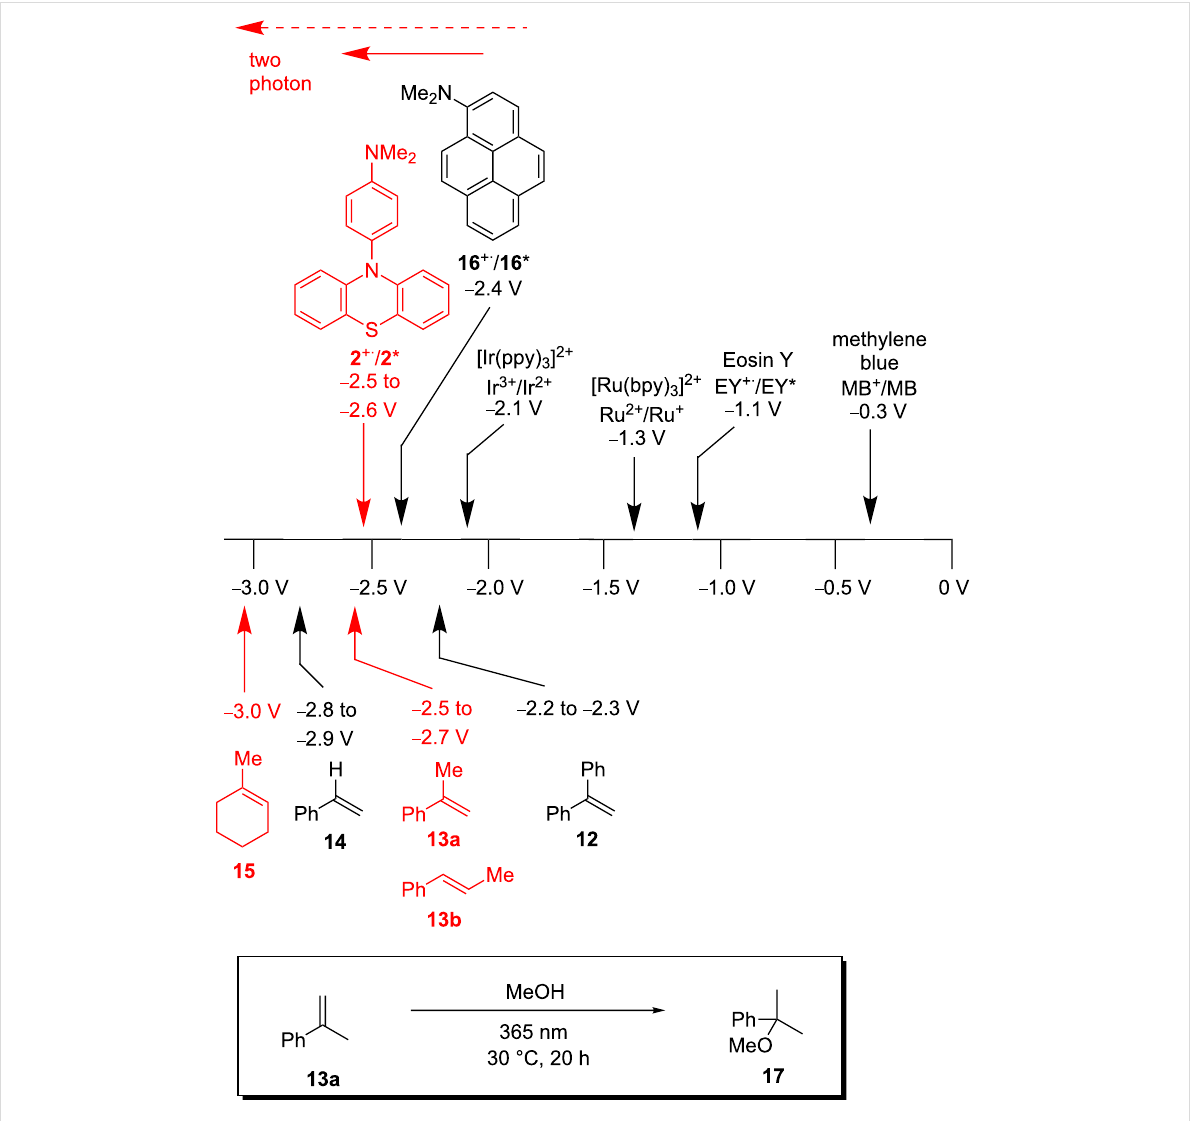
Figure 1: Reduction potentials (vs SCE) of common photoredox catalysts, pyrene 16 and phenothiazine 2 , in comparison to addressable substrate scope 12 – 15 . Bottom: photoredox catalytic addition of MeOH to α -methylstyrene ( 13a ).